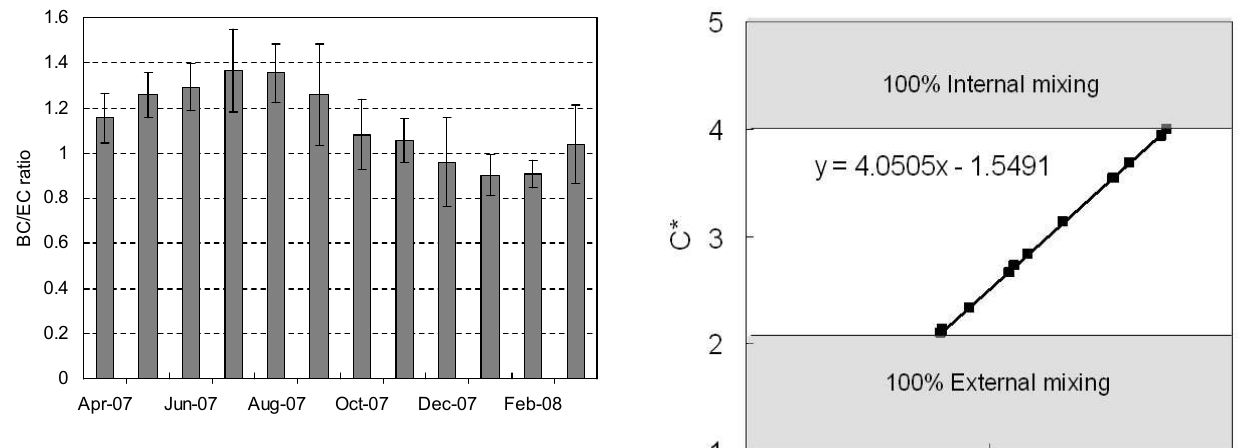
Fig. 2. Temporal variation of monthly average black carbon (BC)/elemental carbon (EC) ratio. Error bars represent standard deviation (1 σ) of BC/EC ratio.